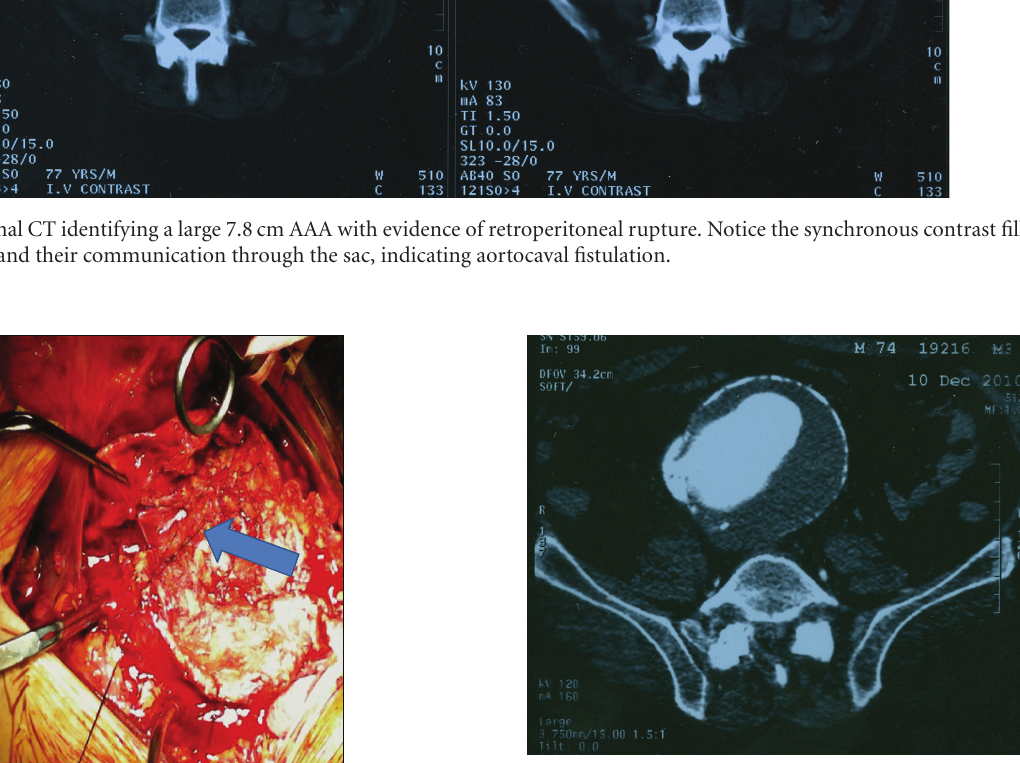
Figure 2: The aortocaval fistula was oversawn from within the sac. Finally, hemostasis was obtained by infrarenal IVC and iliac veins ligation.